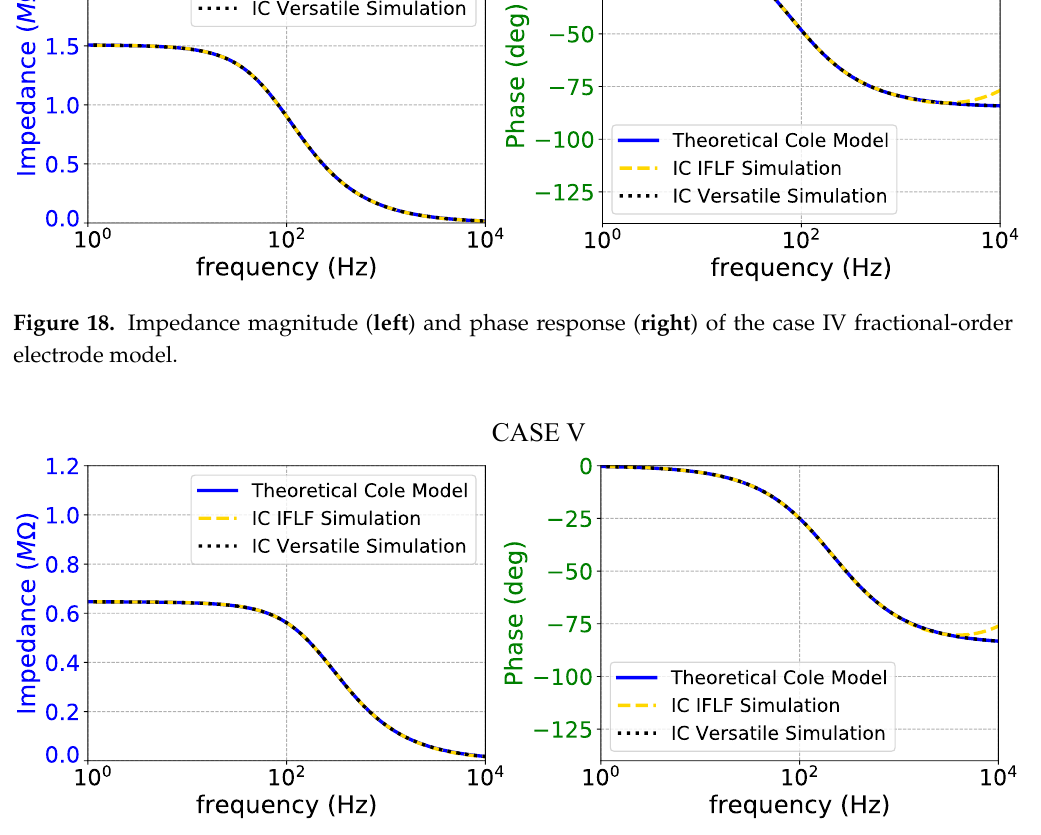
Figure 19. Impedance magnitude ( left ) and phase response ( right ) of the case V fractional-order electrode